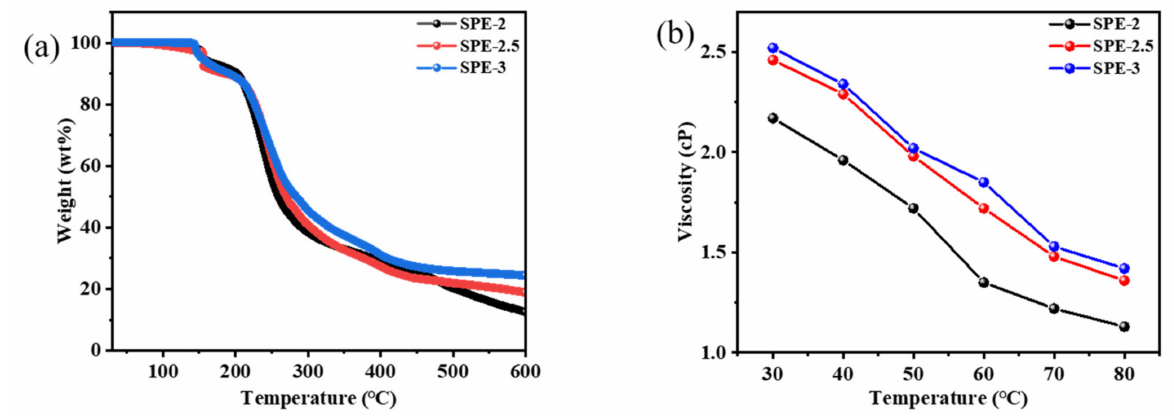
Figure 4. TGA traces ( a ) and viscosity vs. temperature curves ( b ) of SPE-2, SPE-2.5, and